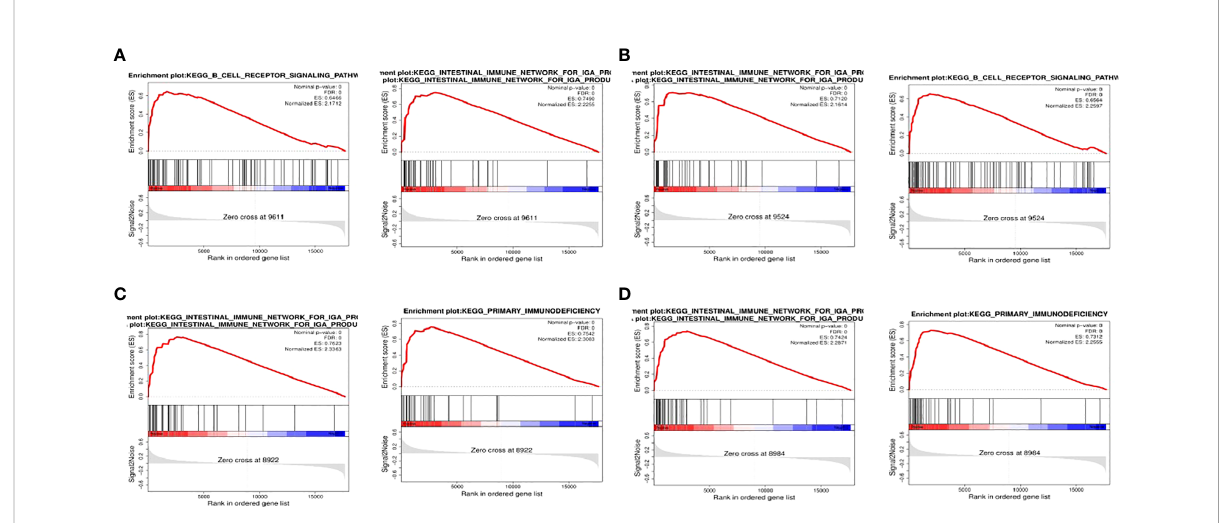
FIGURE 5 GSEA. (A) GSEA results of the top two correlations between BTK and signaling pathway; (B) GSEA results of the top two correlations between CD72 and signaling pathway; (C) GSEA results of the top two correlations between PTPN6 and signaling pathway; (D) GSEA results of the top two correlations between VAV1 and signaling